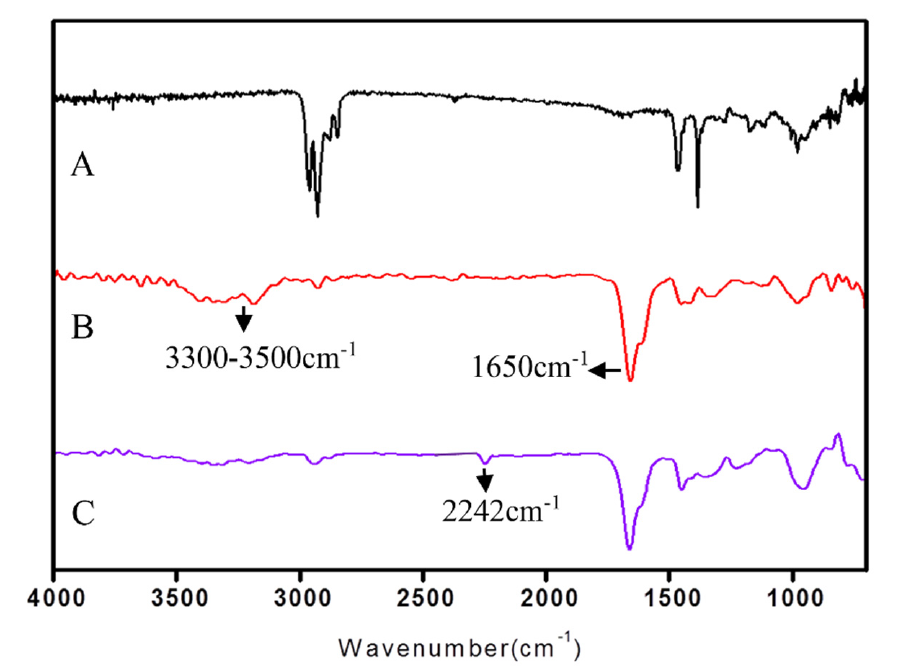
Figure 6. FTIR spectra: (A) blank PP sheet; (B) PP-g-AAm 101%; (C) PP-g-P (P (AAm-co-AN) contains 23% AN). FTIR was applied for the determination of the PAAm:PAN ratio after the dehydration of the AAm-grafted samples.